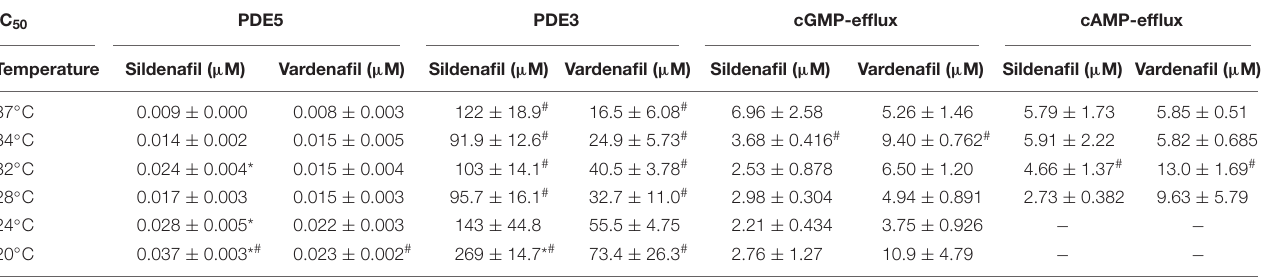
TABLE 4 | IC 50 -values for inhibition of phosphodiesterase-5 (PDE5), phosphodiesterase-3 (PDE3), and inhibition of cAMP- and cGMP-efflux at temperatures ranging from 37 ◦ C to 20 ◦ C.